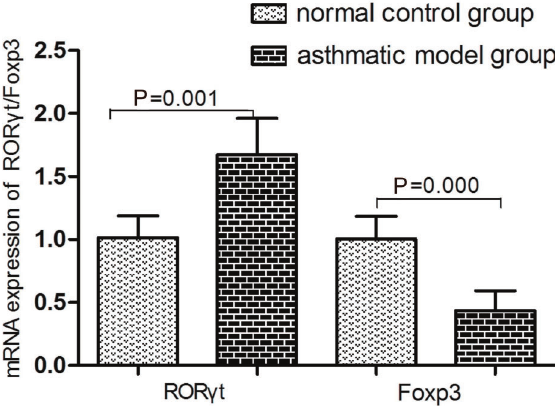
Figure 8. BALB/c mice were sensitized and challenged with ovalbumin. mRNA expression of ROR g t and Foxp3 in lung tissues was determined by real-time PCR analysis. Data are reported as means ± SD ( t